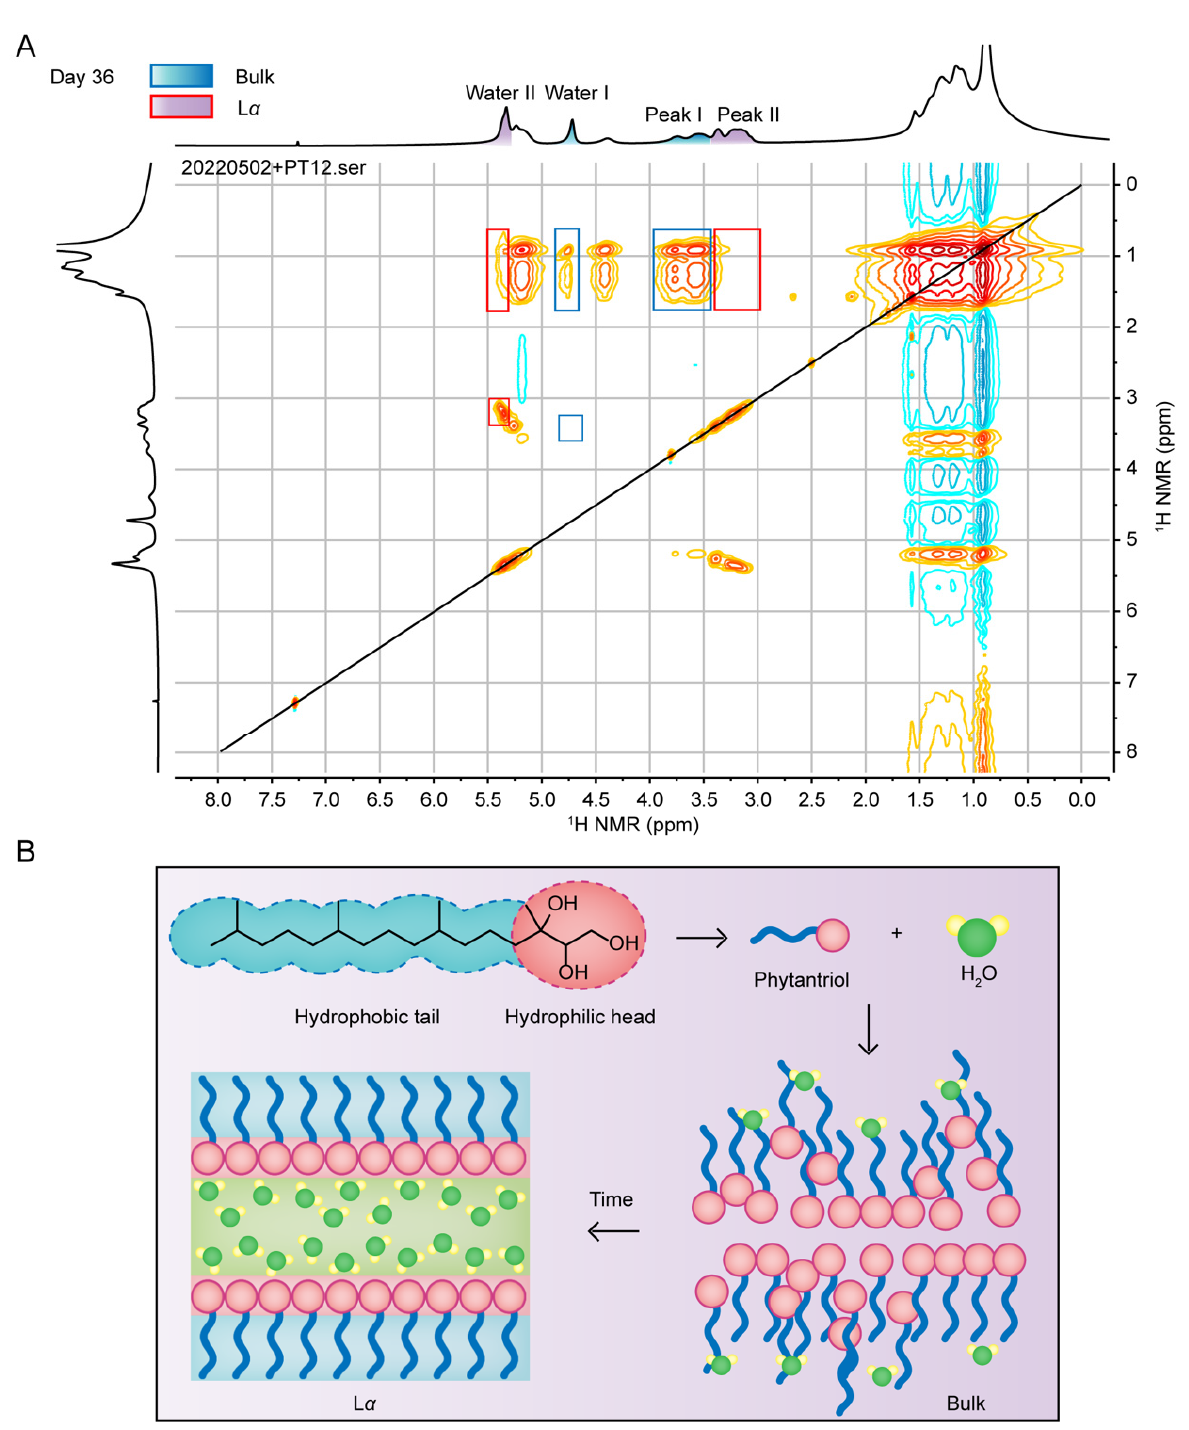
Figure 5. ( A ) A two-dimensional 1 H- 1 H NOESY spectrum of PT12 on day 36. ( B ) The bulk structure and anisotropic phase model of a phytantriol/water system.